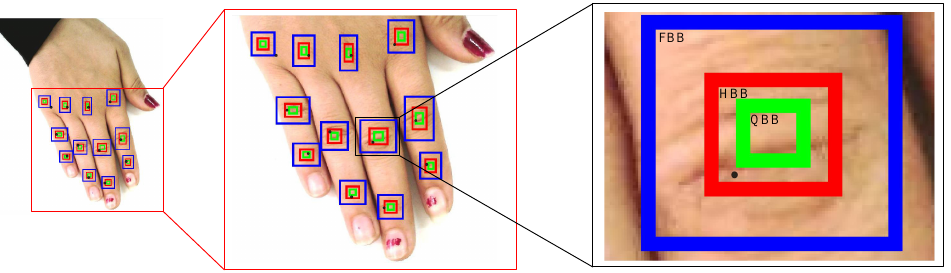
Figure 4. Illustration of calculating point-form metrics with black-dots as the detected keypoints from Openpose, blue-, red-, and green-colored boxes as the FBB, HBB, and QBB, respectively (refer to web version of the article for colored